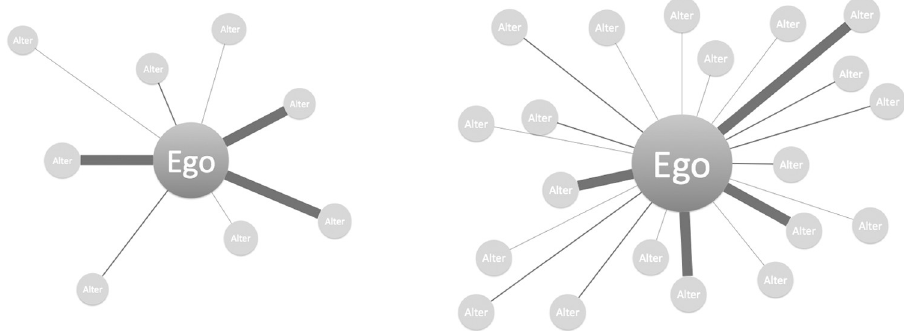
Fig 4. Broader and deeper social networks. Digital communication may alter the structure of social networks (from left to right, above) by making it easier to maintain weak ties (thin connections) and strong ties (thick connections)